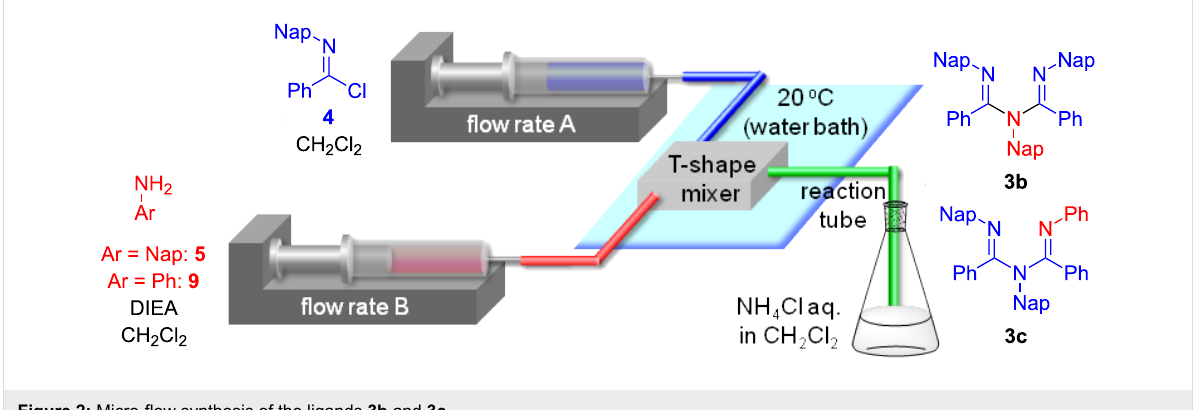
Figure 2: Micro-flow synthesis of the ligands 3b and 3c .